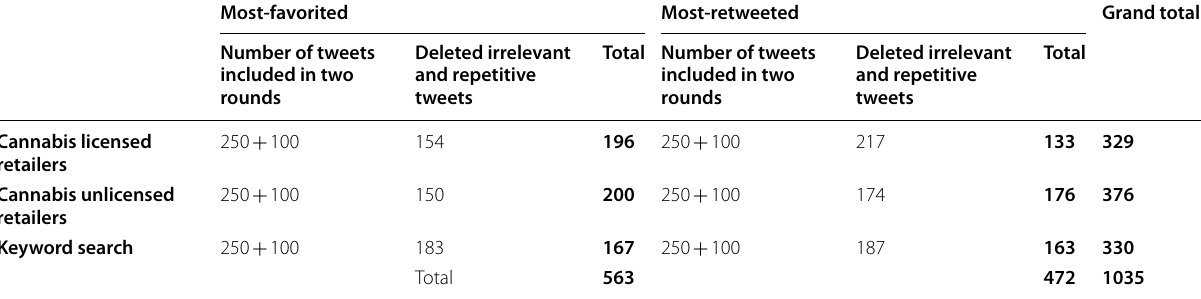
Table 1 Sampling tweets for content